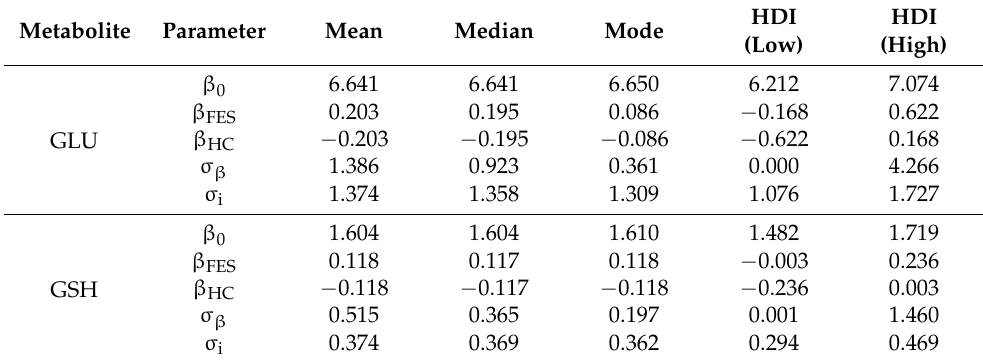
Table 2. Parameter estimates (posteriors) of the hierarchical Bayesian linear model of the effect of group on glutamate (GLU) and glutathione (GSH) levels.